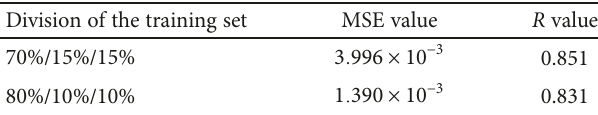
Table 7: Values of MSE and R depending on the division of the training set (for eight neurons in the hidden layer and TRAINLM algorithm) in model ANN 2.